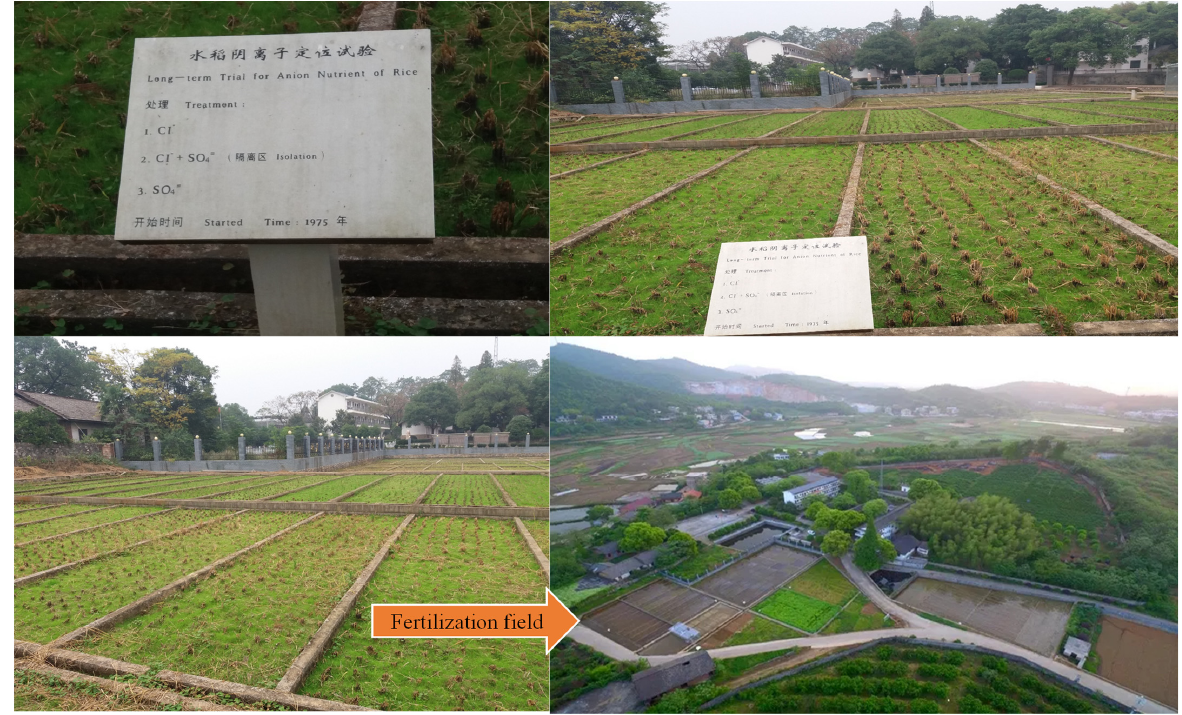
Figure 1. Anion long-term experiment at the Qiyang Red Soil Experimental Station, Hunan Province, China. Table 1. Fertilizer amounts used in the three treatments in the long-term experiment (plot area: 25 m 2 ) and the pot experiment.